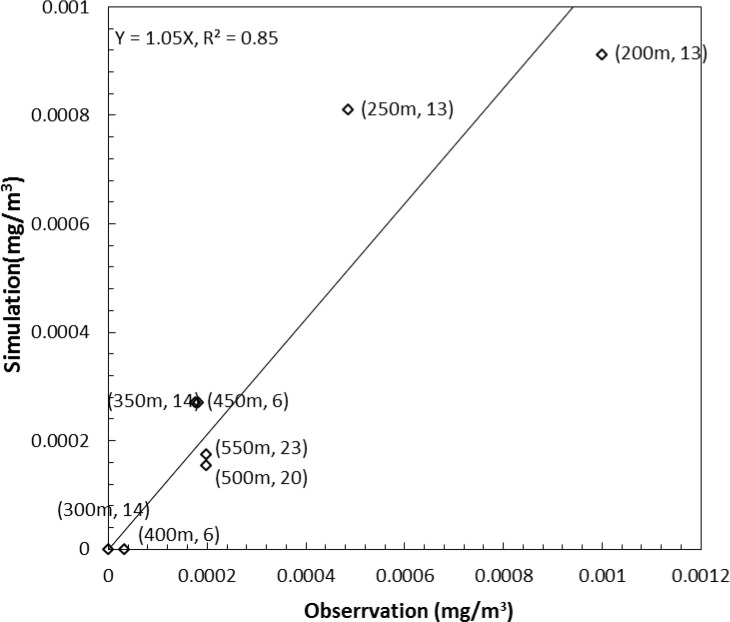
PM10 concentration comparison between observation and simulation at different heights from 11:13 MDT to 13:13 MDT on April 1, 2008 (MDT: Mountain Daylight Time).The concentration of the simulation at each height was calculated for the downwind plume area that intersected with the concentration of observation. Heights were from 200 to 550 m. The lables on the graph are heights following number of compared data points (e.g., 350 m, 14: The number of compared data points (number of corresponding observed data points to a compared simulation data point), was 6 at 450 m).